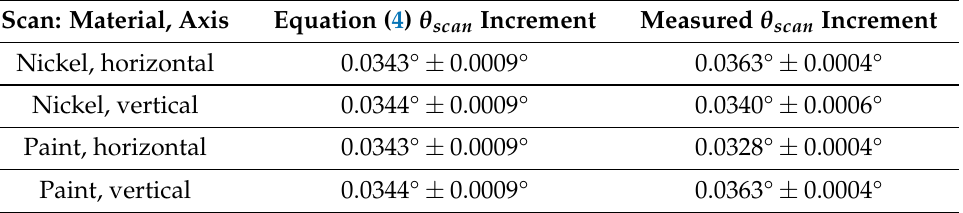
these reported 16